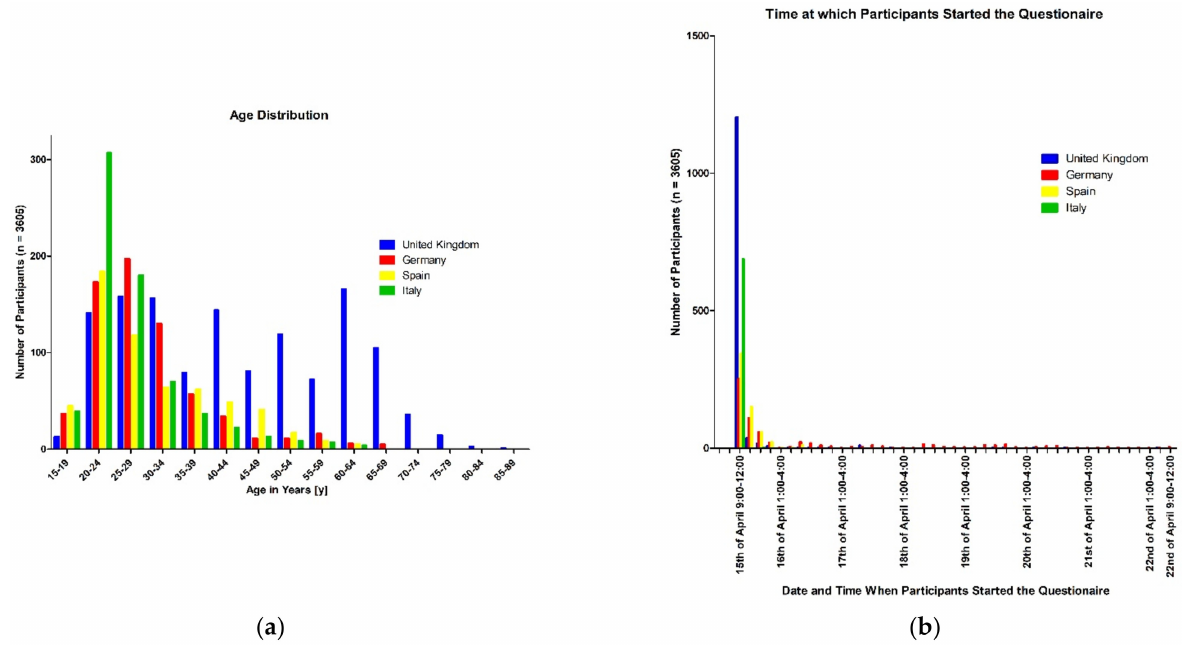
Figure 2. ( a ) Age distribution of participants; ( b ) date and time at which participants started the questionnaire.